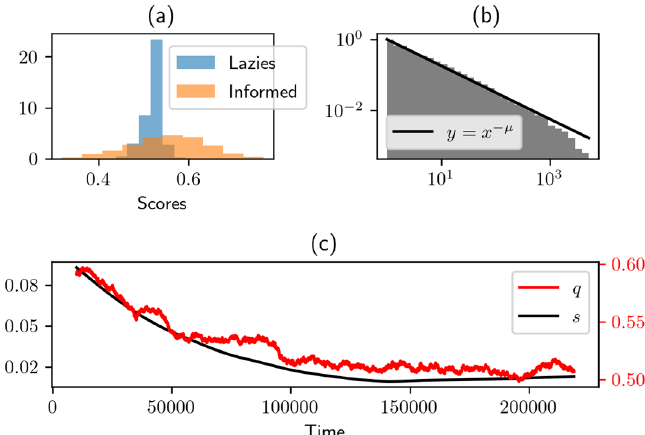
Figure 3. ( a ) Distribution of scores, ( b ) complementary cdf of in-degrees k , and ( c ) dynamics of the model, all for z = .98 , p = .52 . Panel ( b ) reveals that the distribution of in-degrees decays as a power-law k − µ ≈ .75 . A value of µ ≤ 1 means that the first moment of k formally diverges, symptomatic of a “winner-takes- all”